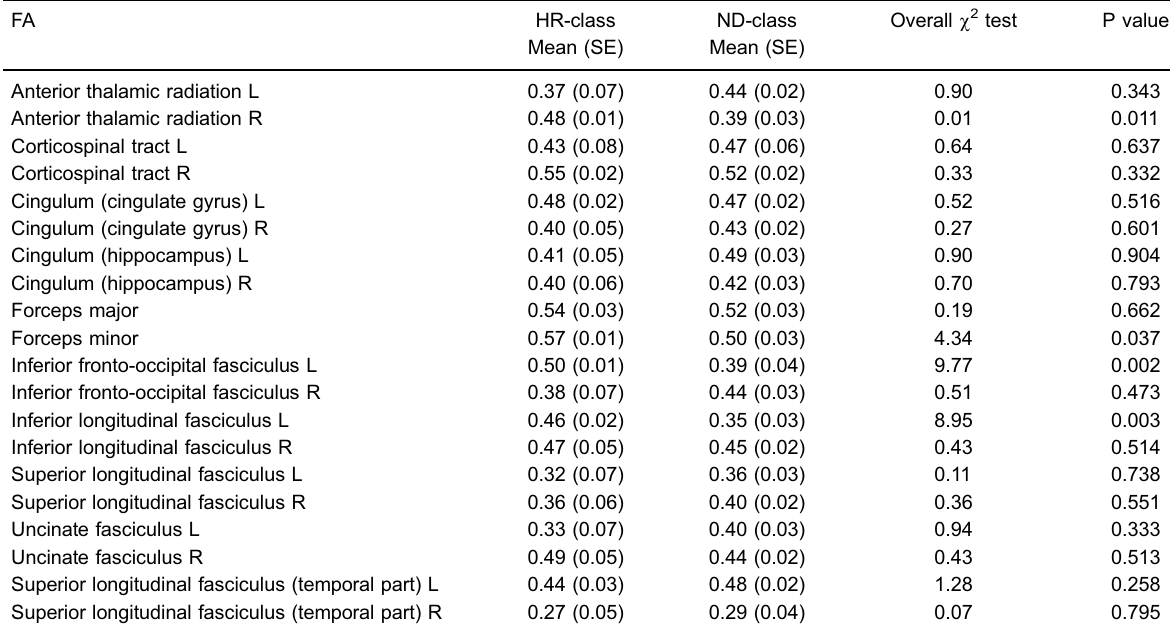
Table 3. Comparison of latent classes in respect to fractional anisotropy (FA) mean values.